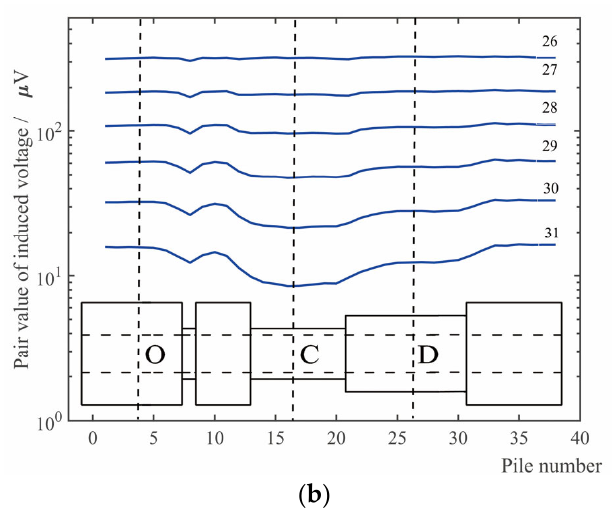
Figure 11. Time slices of voltage of receiving coil in the inspection of tubing plus casing: ( a ) Corroded tubing plus undamaged casing; ( b ) Undamaged tubing plus corroded casing.